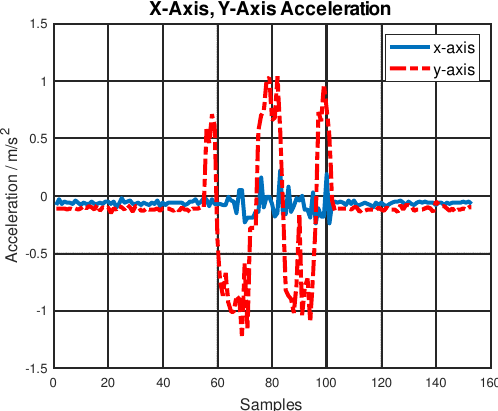
decelerate along the y -axis, as shown in Figure 11. For better localization results, BNO055 can be replaced with a more expensive and higher-performance IMU.